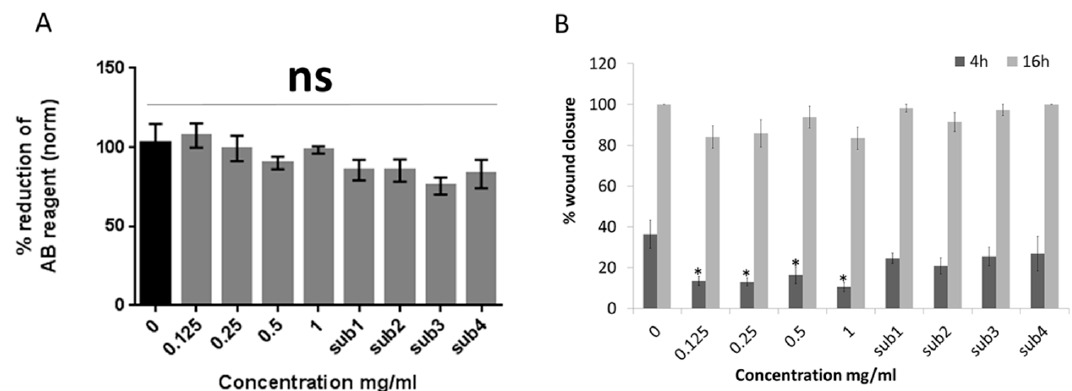
Figure 1. Bevacizumab does not affect the metabolic activity albeit hinders the scratch wound healing of human limbal epithelial cells. alamarBlue (AB) assay results at 24 h after treatment, indicate that there is no statistically significant effect of different Bevacizumab concentrations on limbal epithelial cell metabolic activity ( A ). On the other hand, scratch closure was significantly delayed for all Bevacizumab concentrations at 4 h but not at 16 h timepoint . ( B ). The drug substrate (sub) was used as control in the equivalent amounts corresponding to the four different Bevacizumab concentrations (respectively referred to as sub1–4) For both assays, number of replicates n = 8 and * p < 0.05. Error bars represent standard deviation of the mean.